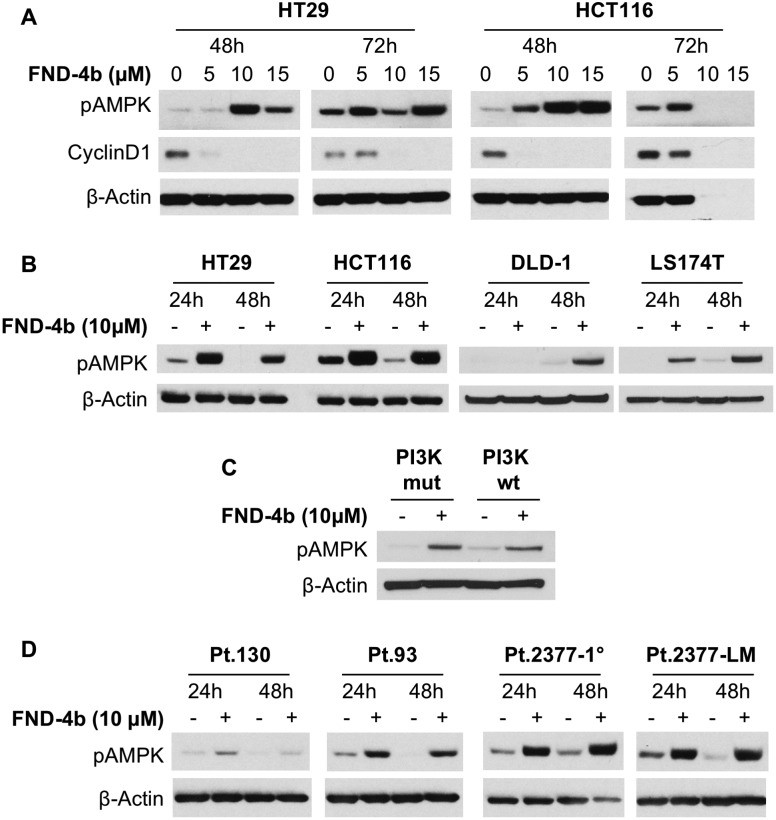
Determining effective treatment dose and duration for commercially-available and PDX-derived colorectal cell lines.(A) Treatment of HT29 and HCT116 cells with FND-4b at varying concentrations for 48h and 72h demonstrated maximal AMPK activation with 10μM FND-4b at 48h. (B) Treatment of HT29, HCT116, LS174T, and DLD1 with 10μM FND-4b for 24h or 48h duration indicated optimal pAMPKα activity at 24h for all cells except DLD1. (C) Treatment of PI3KCA mut/wt DLD1 cells with 10μM FND-4b for 48 h resulted in similar levels of AMPK activation. (D) Treatment with 10μM FND-4b resulted in equivalent AMPK activation at 24h and 48h duration in all four PDX-derived CRC cell lines. Lowest effective treatment dose was 10μM FND-4b for 24h duration. β-actin was used as the loading control for all blots. The images are representative of three independent experiments.